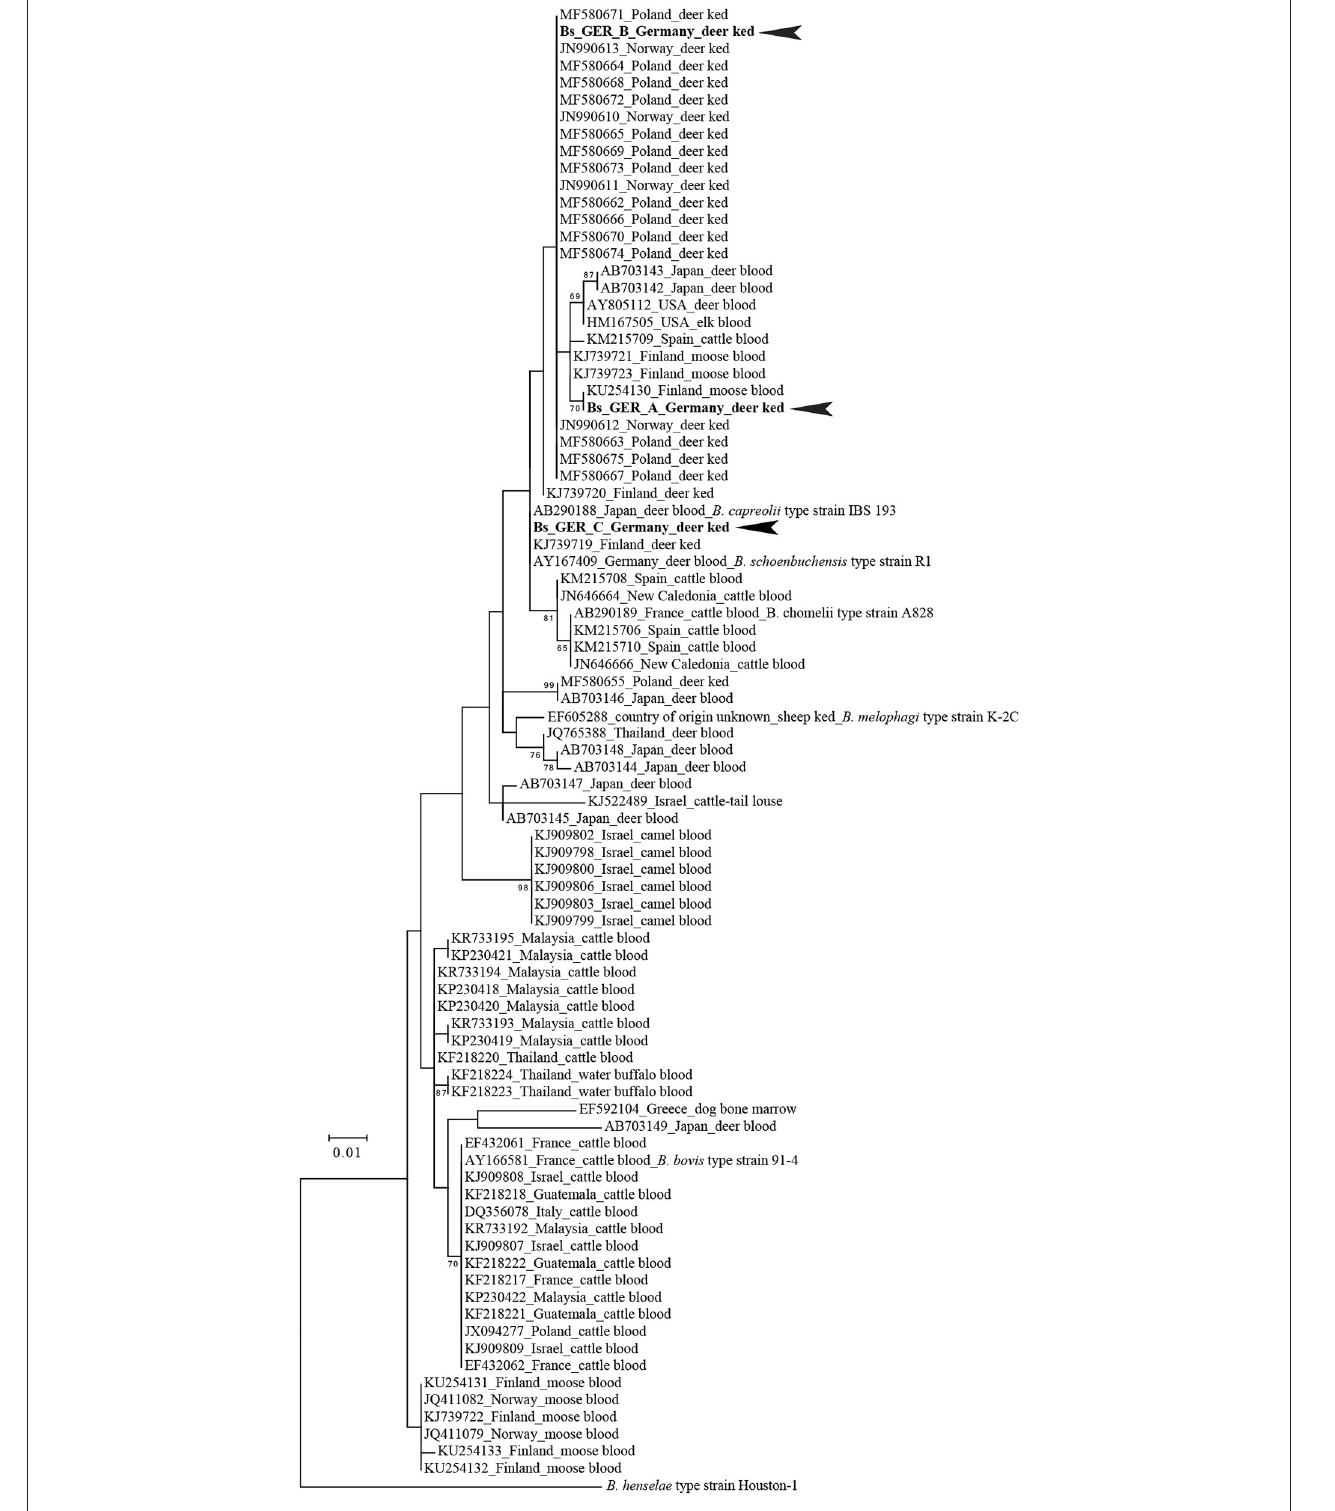
FIGURE 5 | Phylogenetic positions of the type alleles of deer ked-derived partial rpoB fragments among their ≥ 96 % nucleotide identity BLASTN hits. Numbers on branches in the maximum likelihood tree indicate bootstrap support values derived from 500 tree replicas. Bootstrap values > 60 are shown. Scale bar indicates nucleotide substitutions per site. B. henselae Houston-1 was used as outgroup for the Bartonella ruminant-lineage species. Identical phylogenetic positons were obtained whether the tree was constructed based on a 285 bp (shown) or a 406 bp rpoB fragment (see Materials and Methods).